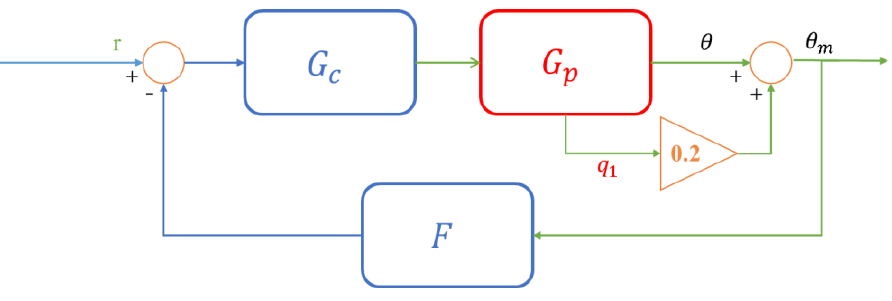
Figure 4. Closed-loop control system .